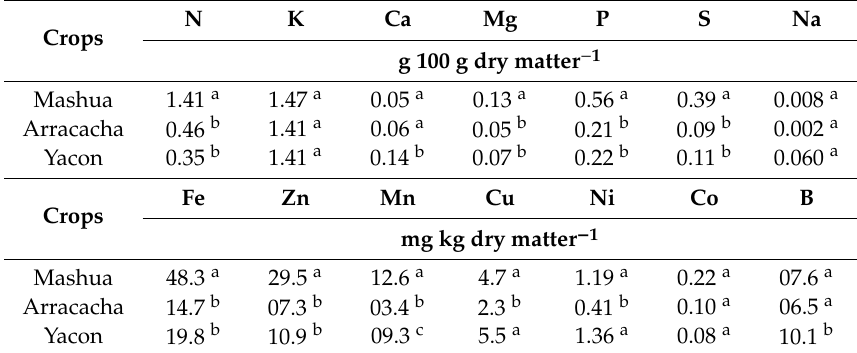
Table 1. Mineral nutrient composition of Andean roots and tubers collected in Bolivia and Peru in 2015, 2016, and 2017. For each species, averages across countries and varieties. Among species, results with di ff erent letters are significantly di ff erent at p < 0.05 (LSD).